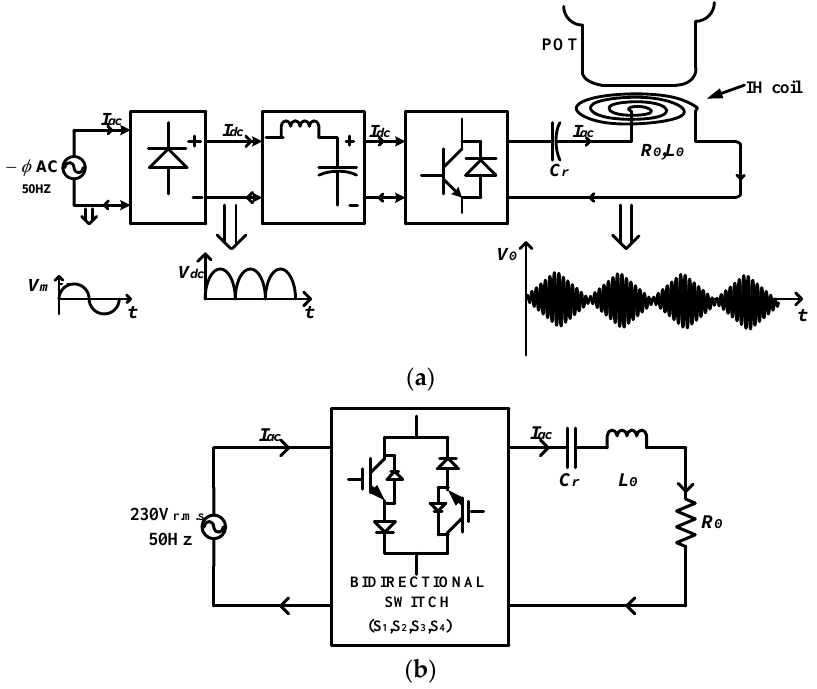
Figure 1. ( a ) Conventional IH Topology and ( b ) Block diagram of proposed topology .